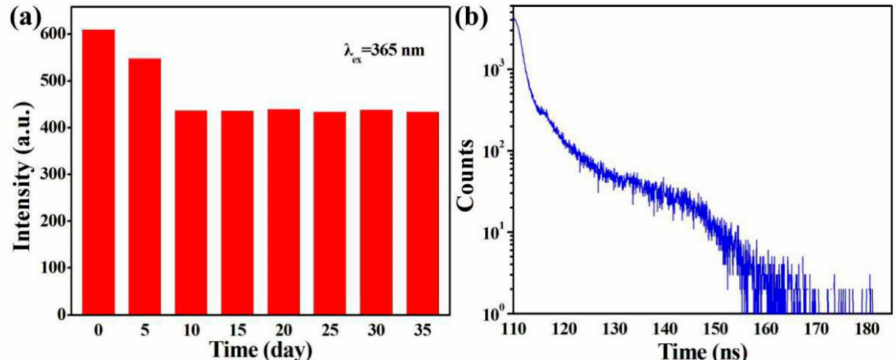
Figure 5. ( a ) Maximum intensity of PL spectra and ( b ) PL lifetime decay curves of